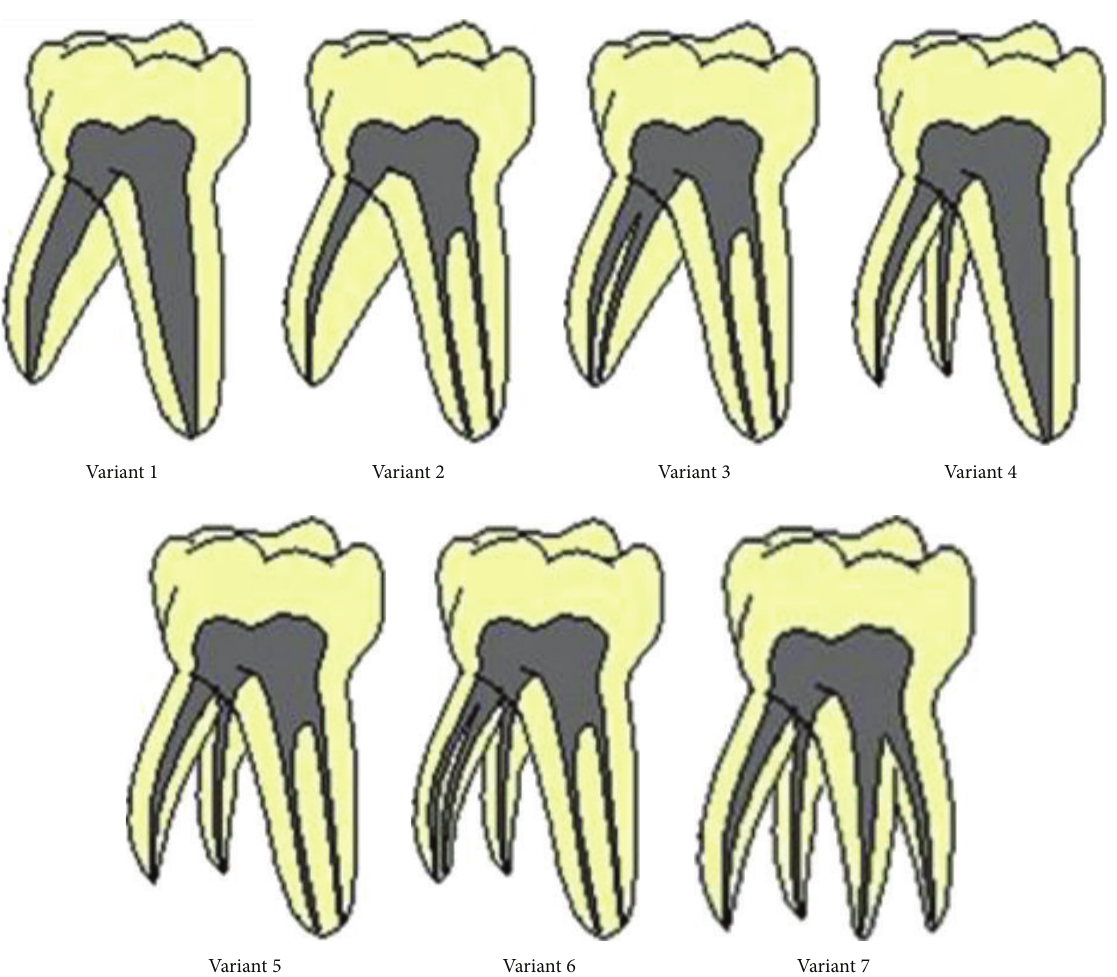
Figure 4: Categorization of the seven variants in primary mandibular second molars by Yang et al.